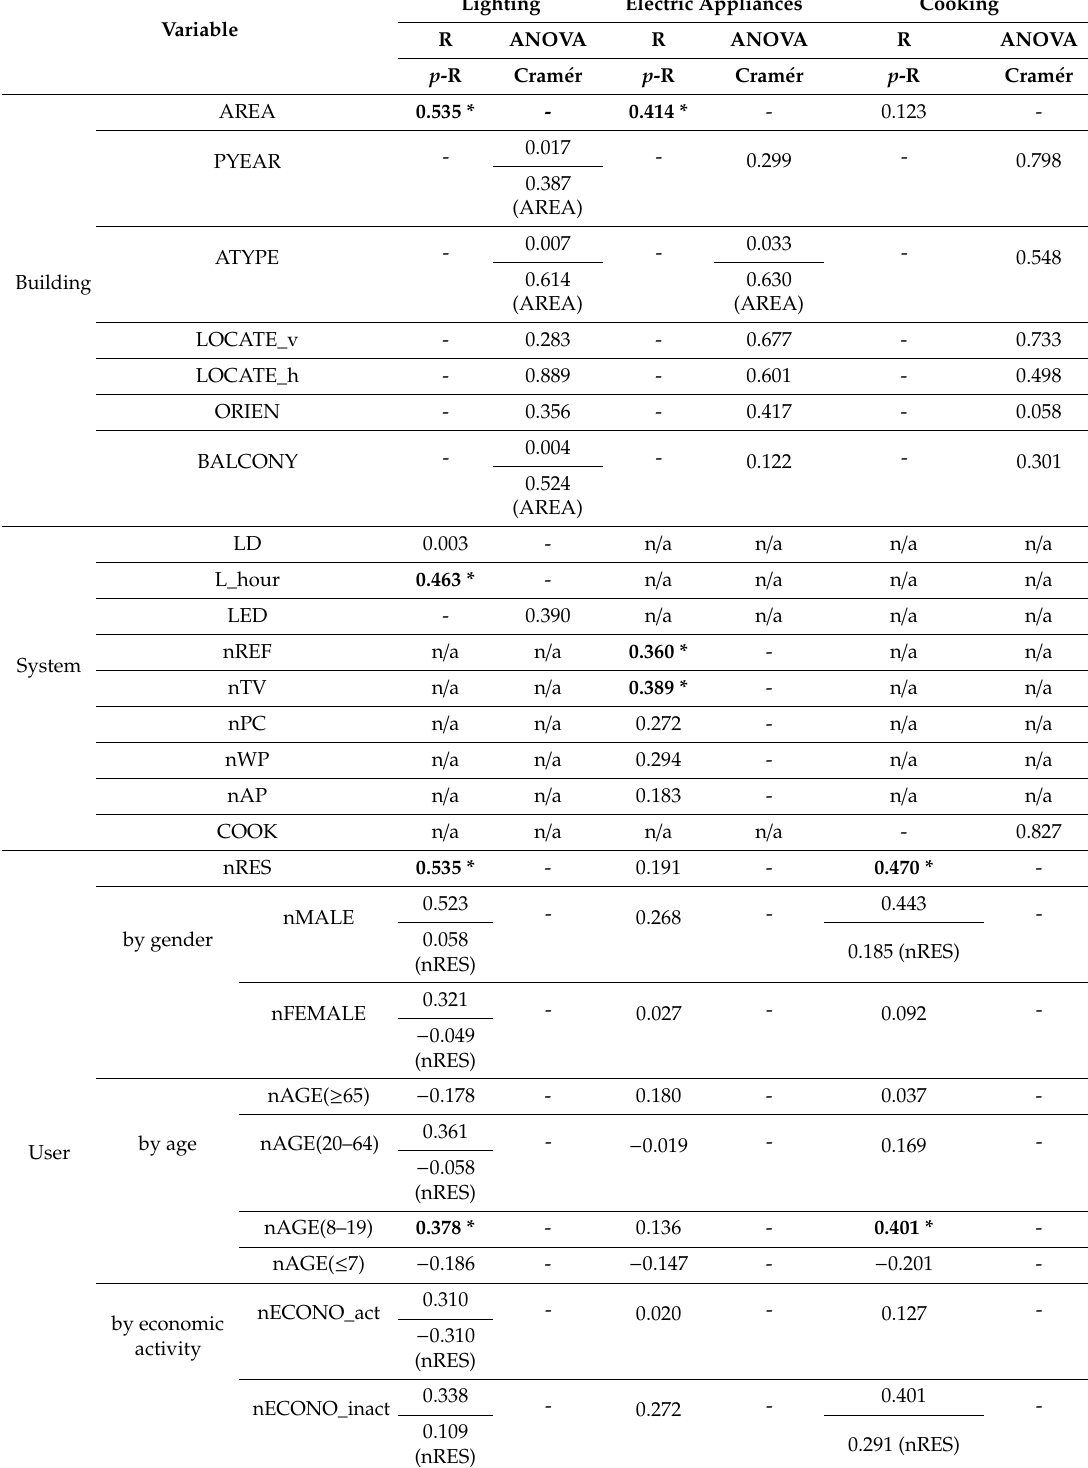
Table 4. Correlation analysis for ratio-scale and AVOVA for nominal-scale results 1,2 : lighting, electric appliances, and